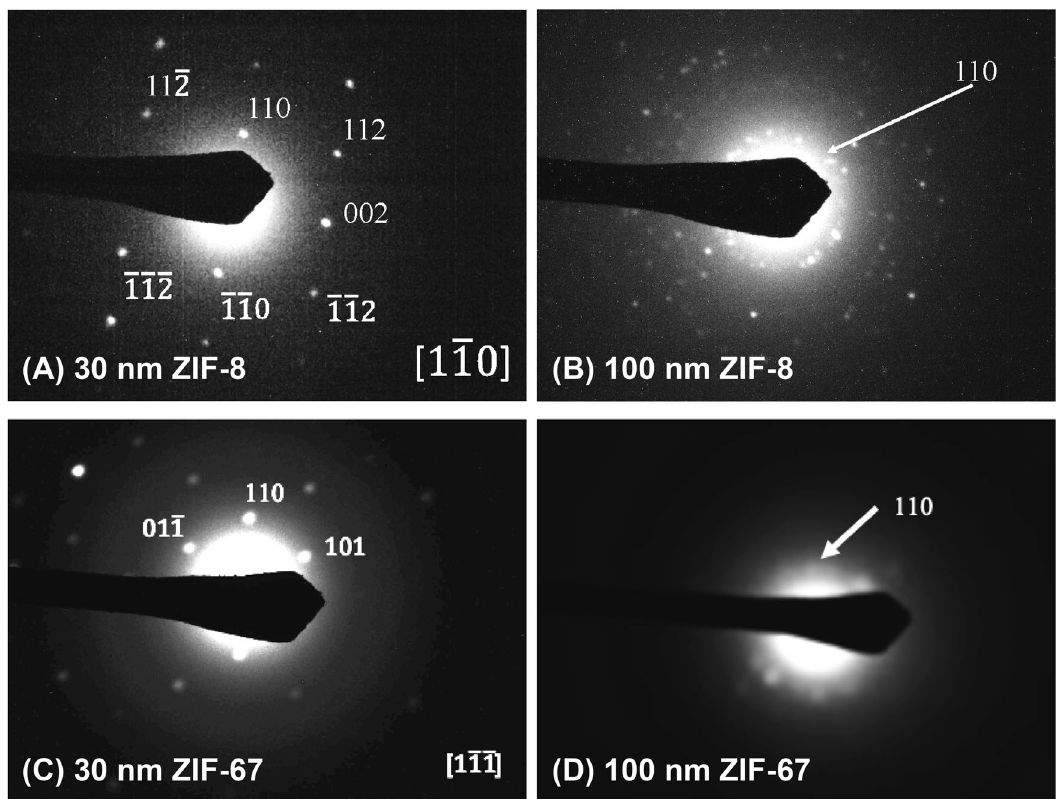
Fig. 5 Selected area electron diffraction (SAED) patterns. A 30 nm ZIF-8 nanowire, ( B ) 100 nm ZIF-8 nanorods, ( C ) 30 nm ZIF-67 nanowires, and ( D ) 100 nm ZIF-67 nanorods.